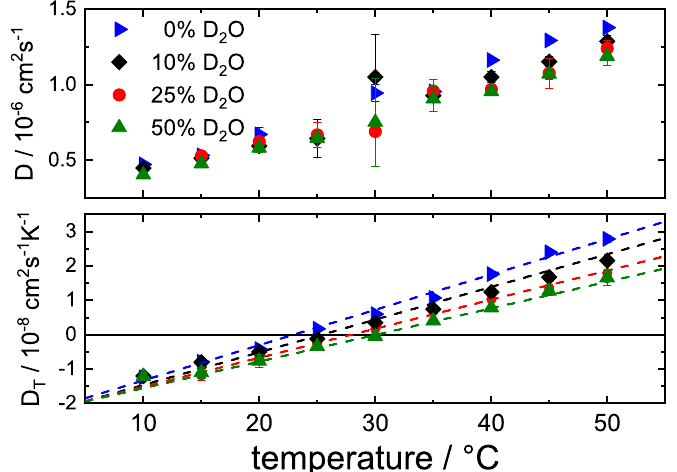
Figure A2. Diffusion coefficient D and thermal diffusion coefficient D T against temperature for streptavidin (39 mg/mL) in buffer solutions with varying percentages of D 2